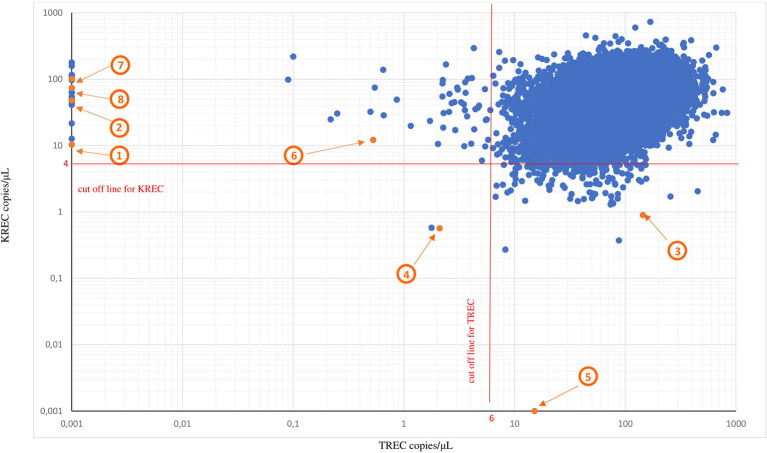
TREC and KREC copy numbers/μL from the first DBS and final diagnosis in eight newborns with severe PID. TREC and KREC copy numbers from the first DBSs.* Red lines represent cutoff values for TREC copies/μL (cut off value 6 copies/μL) and KREC (cut off value 4 copies/μL), respectively. Orange dots represent eight positive results from the first DBSs with T and/or B cell lymphopenia confirmed on flow cytometry. 1—T-BlowNK+ SCID; 2—TlowBlowNK+ CID; 3—AR agammaglobulinemia; 4—Nijmegen breakage syndrome; 5—Transient B-cell lymphopenia due to mother's immunosuppression; 6—T- and B-cell lymphopenia due to prematurity; 7—Transient T- cell lymphopenia of unknown reason; 8—False positive of unknown reason.*The samples which had a low number of ACTB (<1,000 copies/μL) and concomitant reduction of TREC and KREC copy numbers were referred to as “inconclusive” because of a lack of DNA and samples were excluded from the graph.